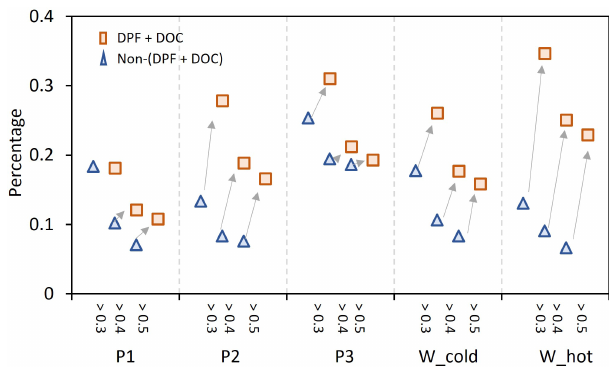
Figure 5. The increment of I/SVOCs with O:C > 0 . 3, 0.4, and 0.5 from non-(DPF + DOC) to (DPF + DOC) vehicles under the low- speed stage (P1), middle-speed stage (P2), high-speed stage (P3), and whole (W_cold and W_cold) driving